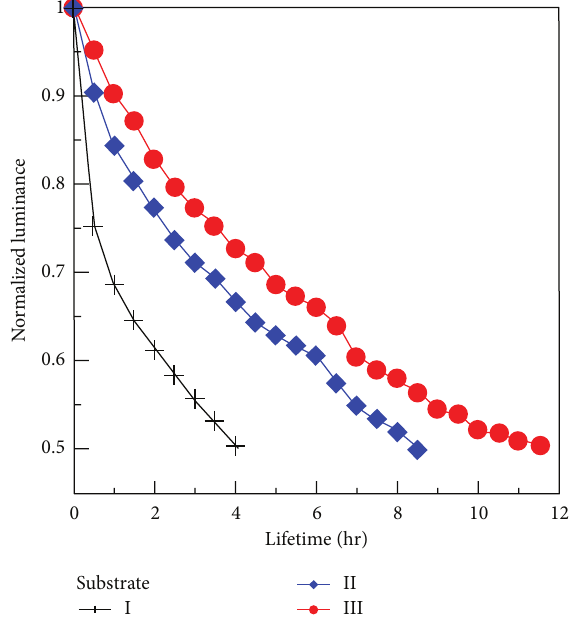
Figure 5: Component lifetime curves of the different substrates.